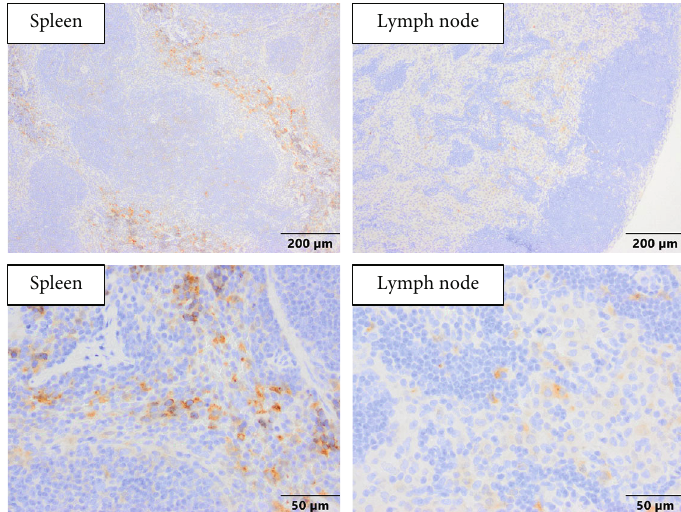
Figure 9: Representative Siglec-15 immunohistochemistry stained sections of the spleen and lymph nodes from 624-MEL+S15 xenografts. Spleen: Siglec-15+ cells were commonly observed in the splenic red pulp with a cytoplasmic to membranous staining pattern; lymph node: faint Siglec-15+ cells were commonly observed in the medulla but occasionally were present in the paracortex or cortical regions of the